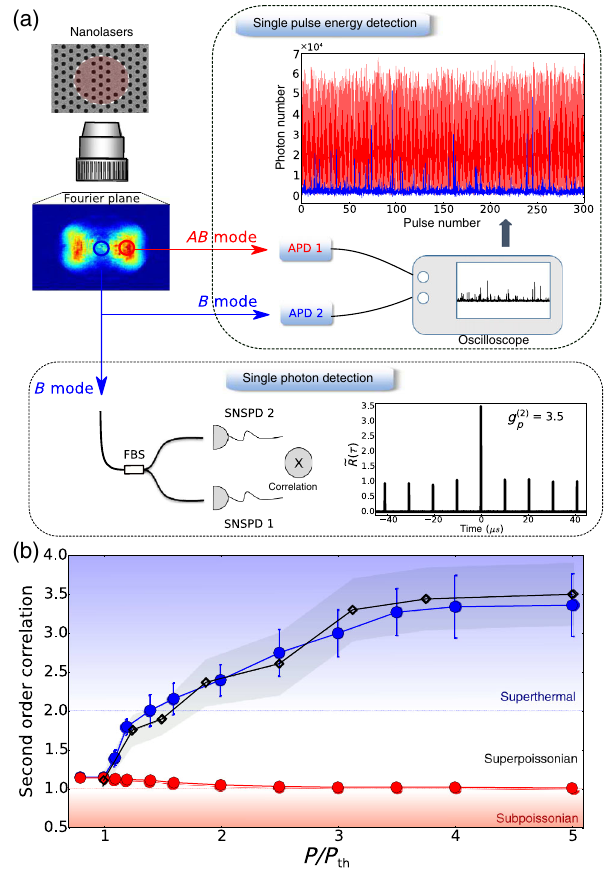
FIG. 2. Experimental autocorrelation results. (a) Top: “ Single- pulse energy detection ” scheme using the pulse-to-pulse meas- urement technique of emitted photon numbers. Simultaneous photon collection from the two modes and further detection with APDs allow us to obtain a sequence of pulses ( p -time trace) 2 Þ “ Single- from which PDFs and g ð p values are computed. Bottom: photon detection ” scheme. Light from the bonding mode is also sent toa HBT setup to provide direct measurement ofsecond-order coherence, used as a cross-check. SNSPD stands for super- conducting nanowire single-photon detector; FBS stands for fibered beam splitter. Inset: Normalized coincidence count histo- 2 Þ gram of the B-mode for P ¼ 4 P . (b) Circles: g ð p for B and AB th modes at different pump powers computed from thevariance of the p -time traces shown in (a). Black diamonds : area under the central peak of the HBT autocorrelation normalized to the average area under secondary peaks (error bars in grey shadow), in good 2 Þ agreement with g ð p measurements (see Supplemental Material [25], Sec. F, for a theoretical